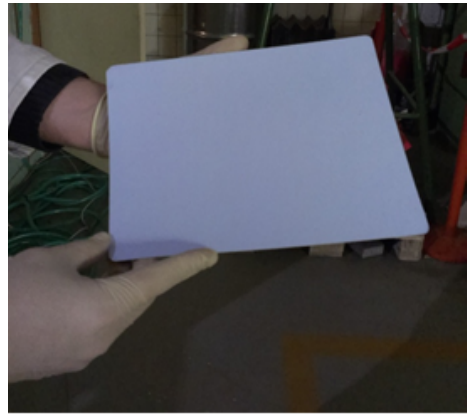
Figure 3. The image plate.